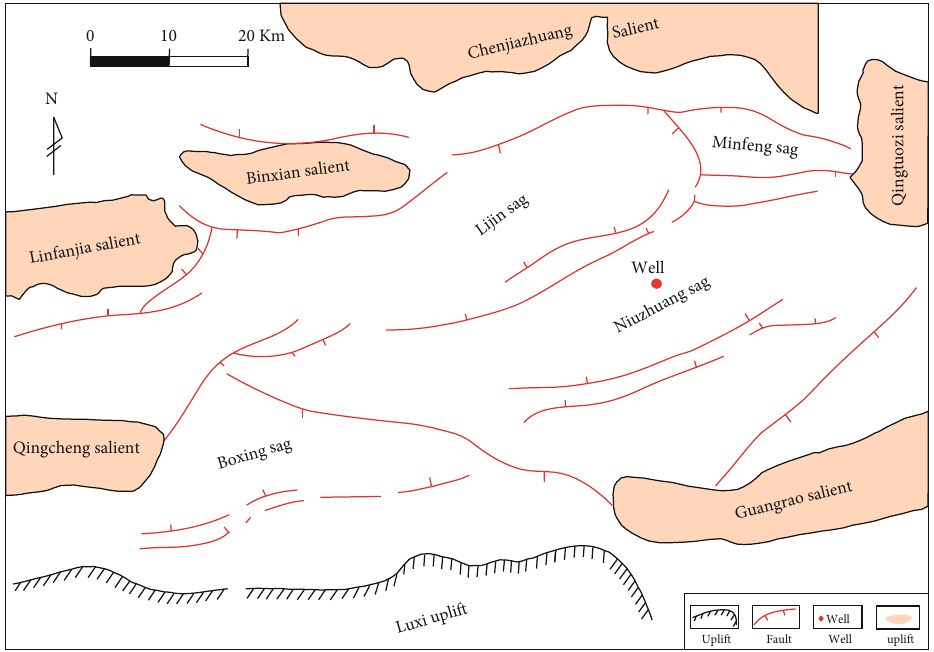
Figure 1: Location map of the study area.